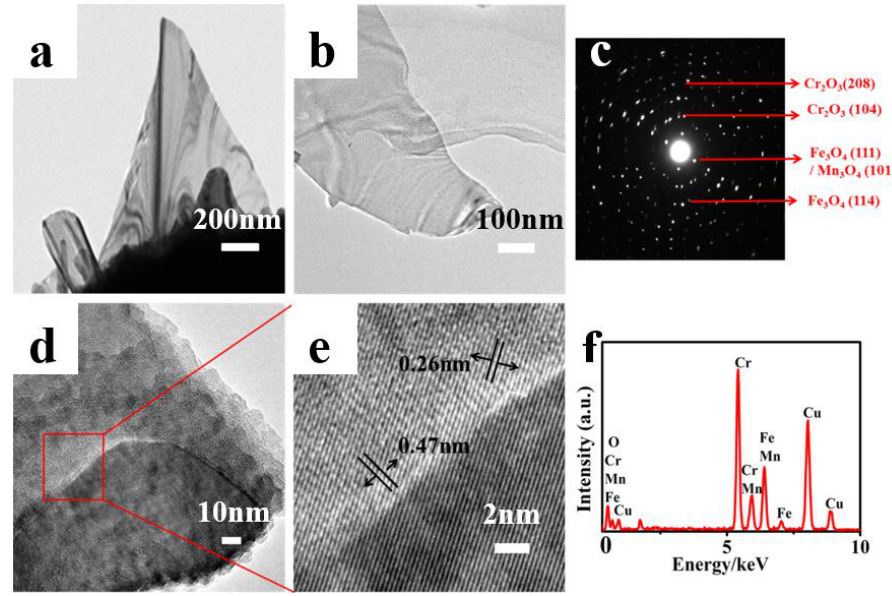
Figure 4. ( a , b ) are the typical TEM images of MONs; ( c ) is the corresponding selected area electron diffraction (SAED) pattern; ( d ) High resolution transmission electron microscopy (HRTEM) image of MONs; and ( e ) is the corresponding enlarged HRTEM of ( d ); ( f ) is the energy dispersive X-Ray (EDX) analysis of MONs. All of the images were obtained from samples prepared at a temperature of 1100 ° C for 1 h.